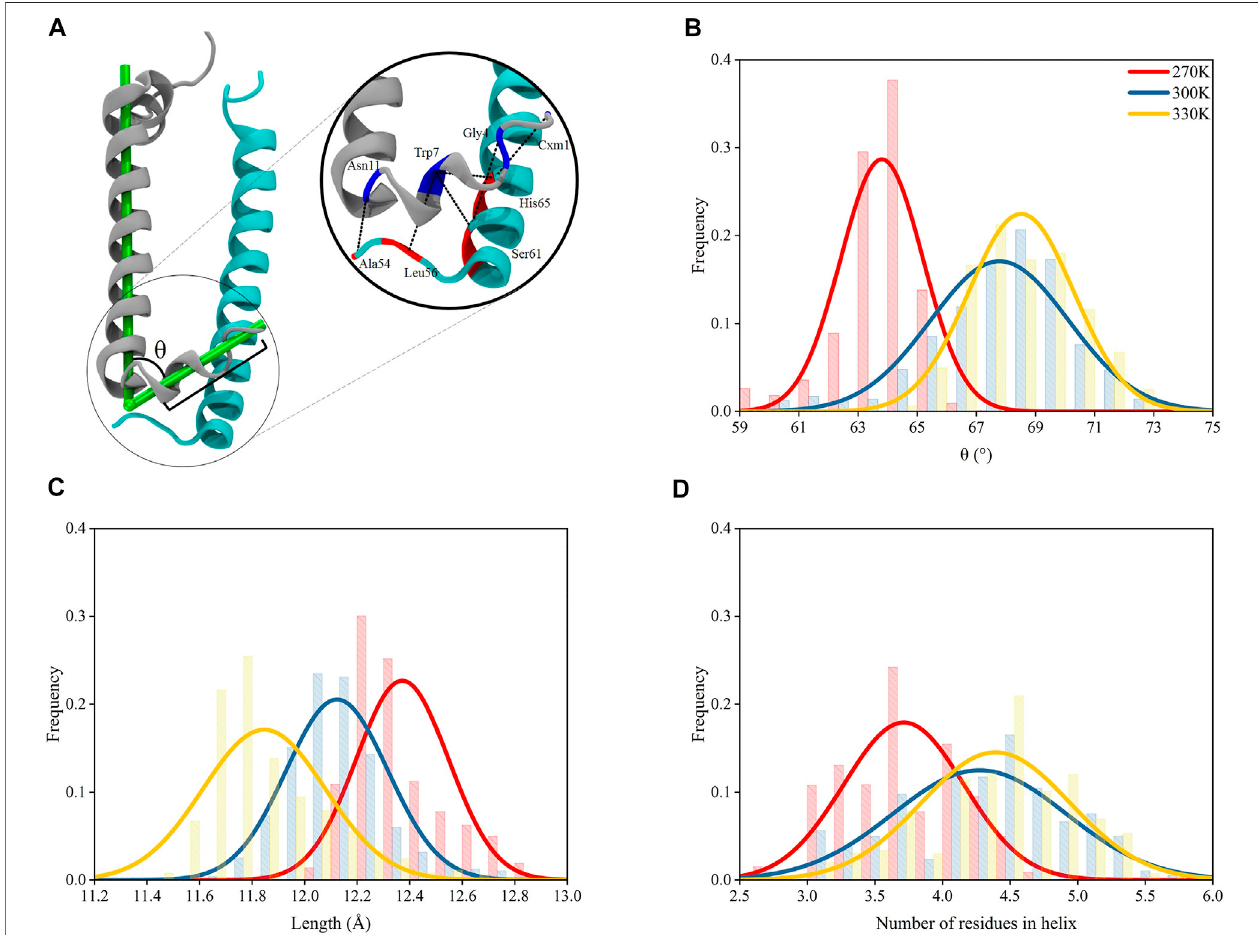
FIGURE 3 | Structural variations for N-terminus of α polypeptide helices. (A) Interactions at the N-terminus of the heterodimer. The L-angle in the N-terminus of α polypeptide helix is de fi ned as the angle between the vector formed by the mass centers of 7th – 9th residues and 1st – 3rd residues and the vector formed by the mass center of12th – 14th residues and 34th – 36th residues, counting from the N-terminusof α chain; the length of helices is de fi ned as the distance between the mass center of 7th – 9th residues and that of 1st – 3rd residues. (B) L-angle distributions under 270, 300, and 330 K. (C) Distributions of lengths of helices (between the mass centers of 7th – 9th residues and 1st – 3rd residues) at N-terminus of α chains under 270, 300, and 330 K. (D) Number of residues in the helical conformation for residue 1 – 9.